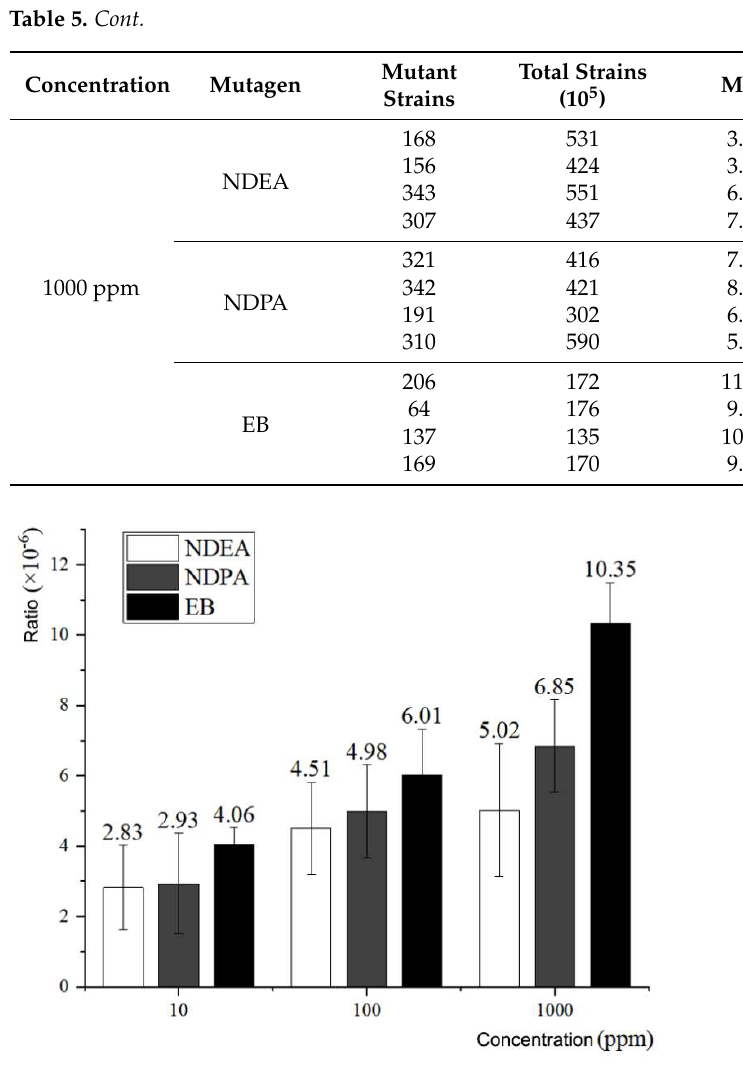
Figure 5. Comparison of rpsL mutation rates induced by NDEA, NDPA, and EB by PCR.